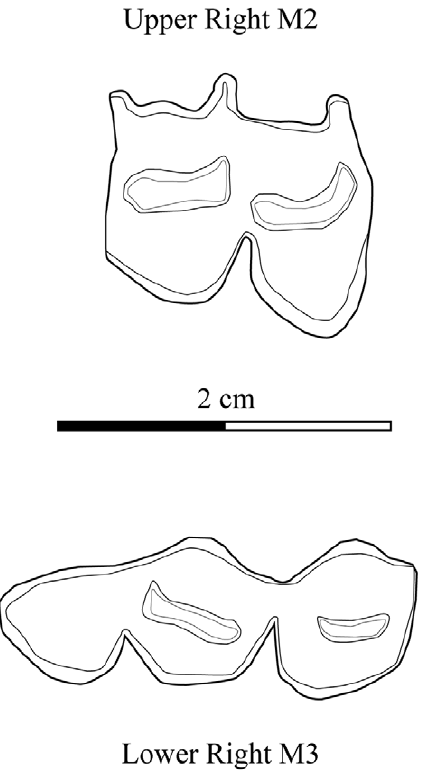
Figure 3. Cheek teeth from sheep/goat at Leopard Cave (Sq. N7, Layers 5 & 6).